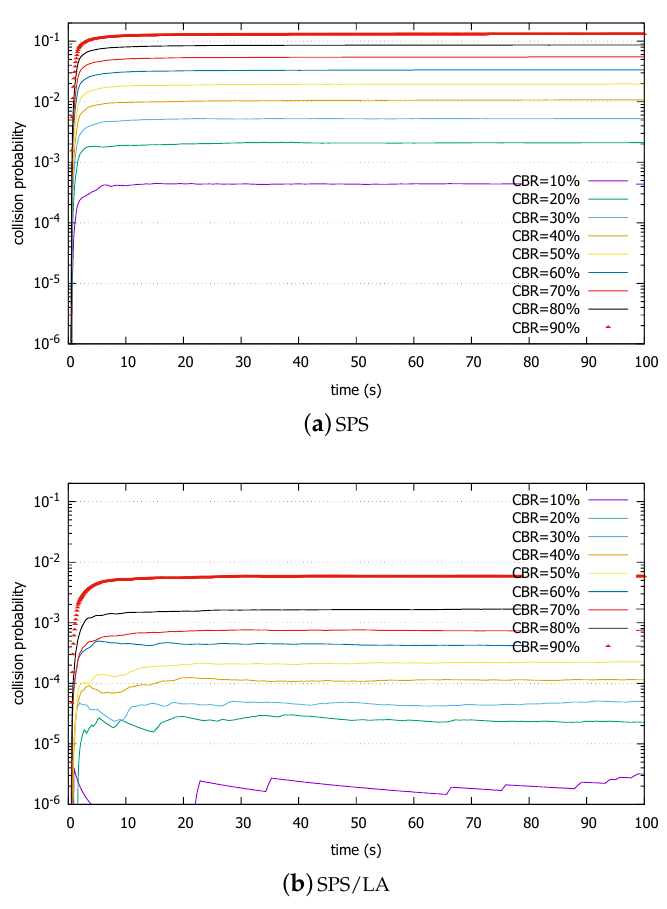
Figure 8. Packet collision rates comparison in ( a ) SPS and ( b ) SPS/LA, heavy